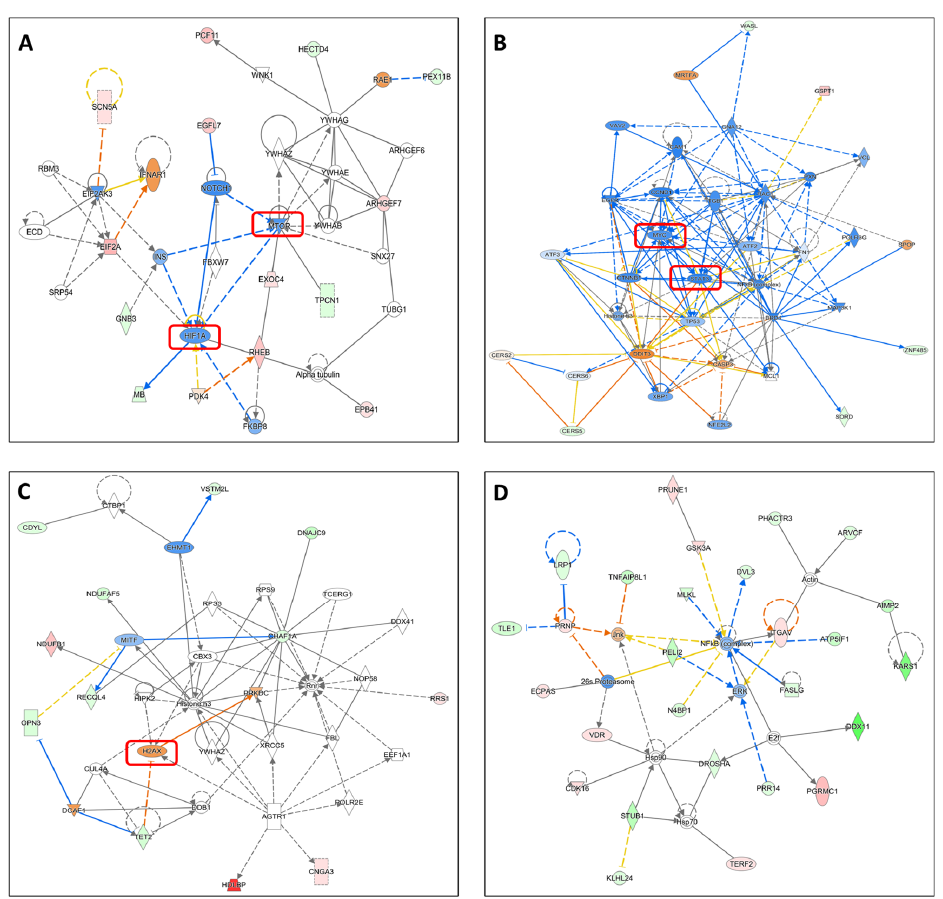
Figure 5. Microarray analyses. ( A – D ): Altered cellular networks in CCRF-CEM cells incubated with 2.5 µM dimer isoniazide. The compound downregulates the expression of several cancer-associated factors, such as MYC , HIF1A , STAT3 , and MTOR, while increasing the expression of others, such as H2AX . Blue and green ions indicate inhibition or downregulation . Red icons indicate activation or upregulation .